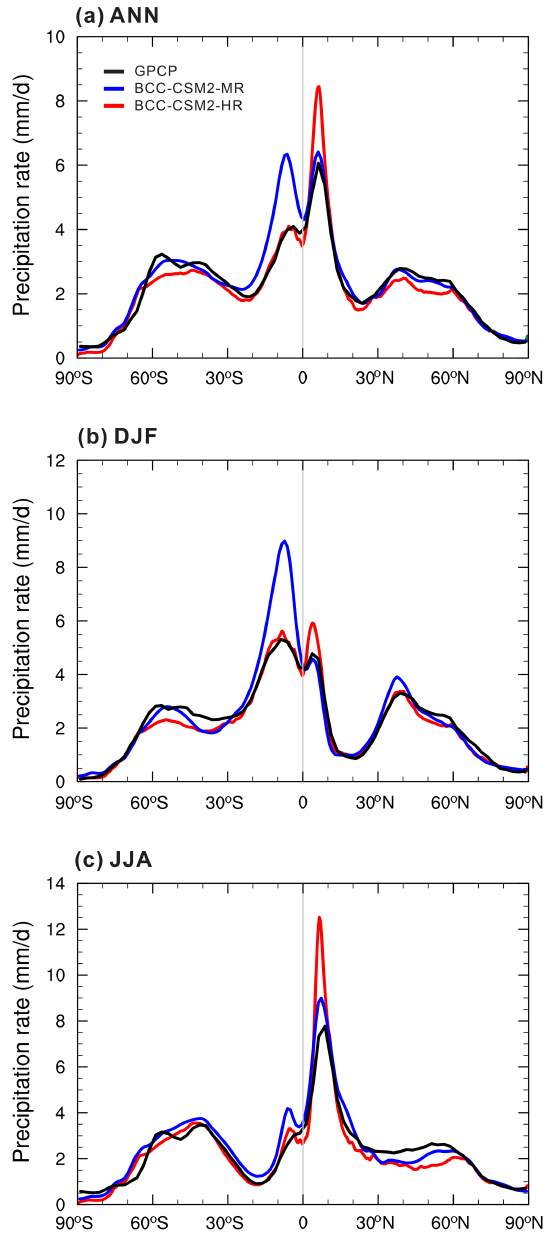
Figure 8. The 1995–2014 averaged zonal mean precipitation rate (mmd − 1 ) for (a) the annual mean, (b) December–January– February, and (c) June–July–August. The solid black lines denote GPCP data, and the colour lines show BCC-CSM2-MR (blue) and BCC-CSM2-HR (red) simulations. Units: mmd − 1 .